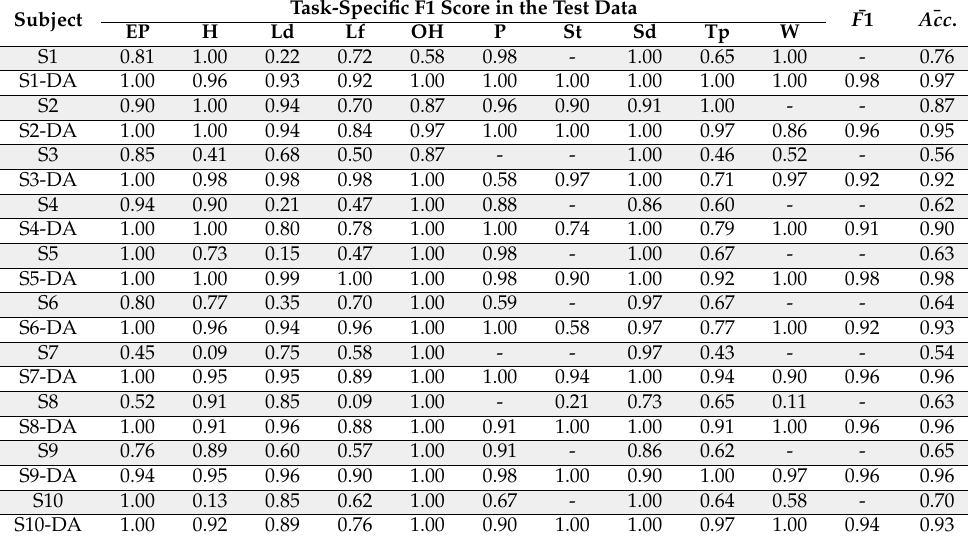
Table 3. Cross-sensor classification performance. Abbreviations: EP: electrical panel, H: hoisting, Ld: ladder, Lf: lifting; OH: overhead; P: pushing; St: sitting; Sd: standing; Tp: typing; W: walking (For some of the cases, “-” has been reported as task-specific F1 score, which means that the denominator of the precision or recall for that specific case was